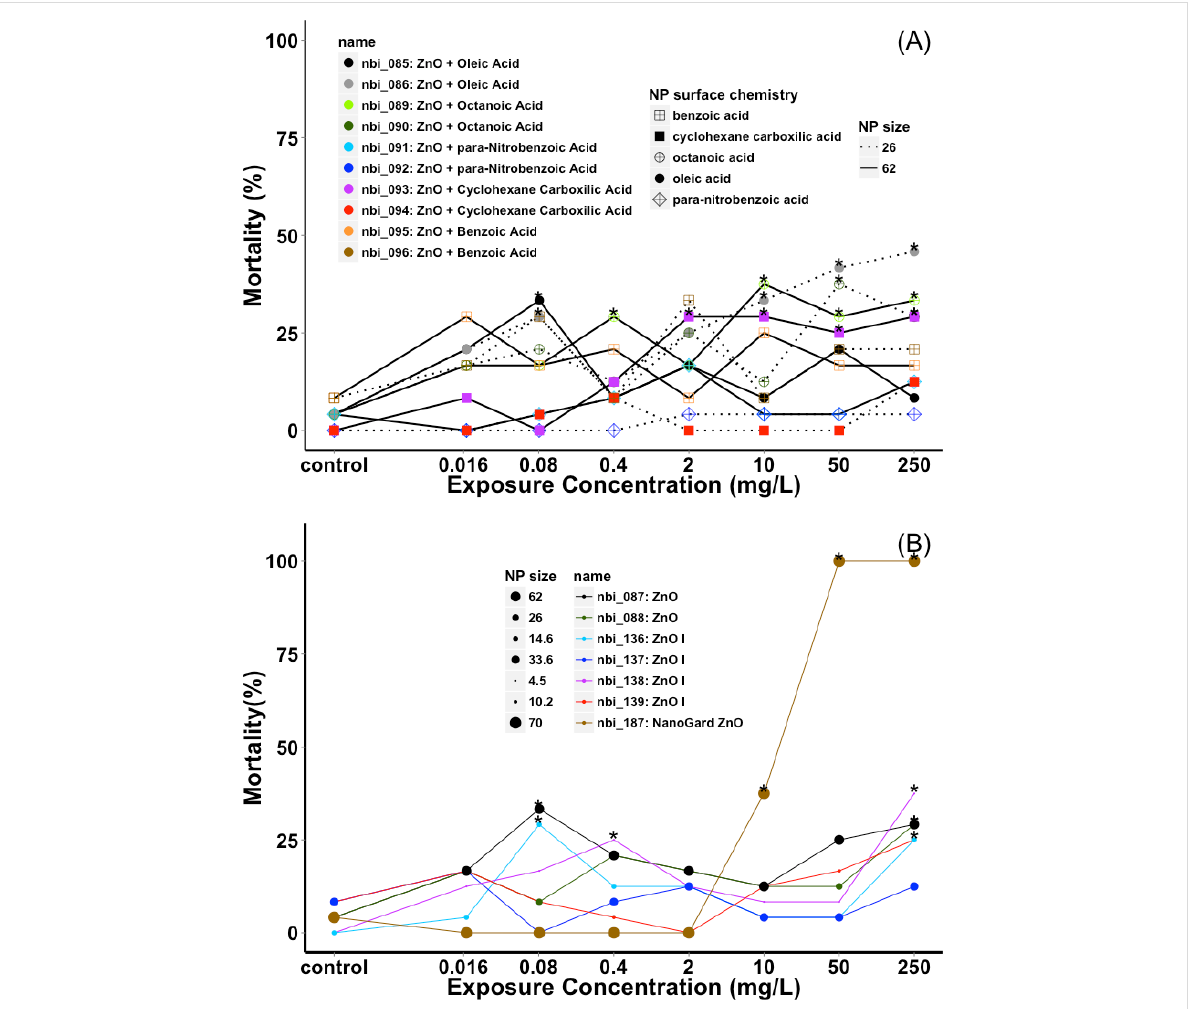
Figure 3: Zebrafish mortality at 120 hpf following exposure to: (A) ZnO NPs with and (B) without surface modification.